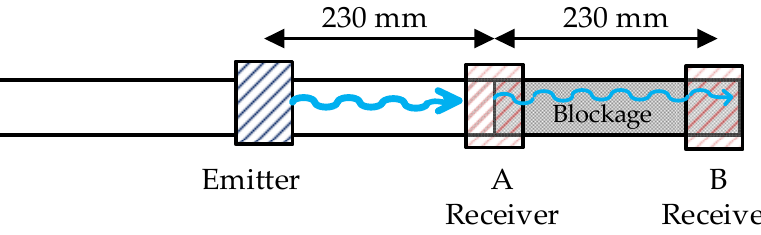
Figure 14. Workbench used for the blockage characterization.